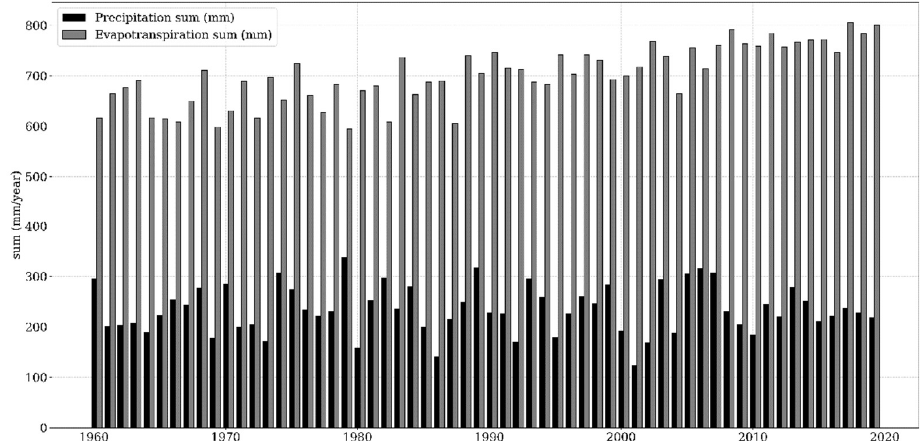
Figure 10. Deviation of the sum of annual precipitation from 1951–1980 average since 1960. Data is from the meteorological station of Yakutsk (World Metrological Organization Index: 24959; 62.0866°N, 129.7500°E).